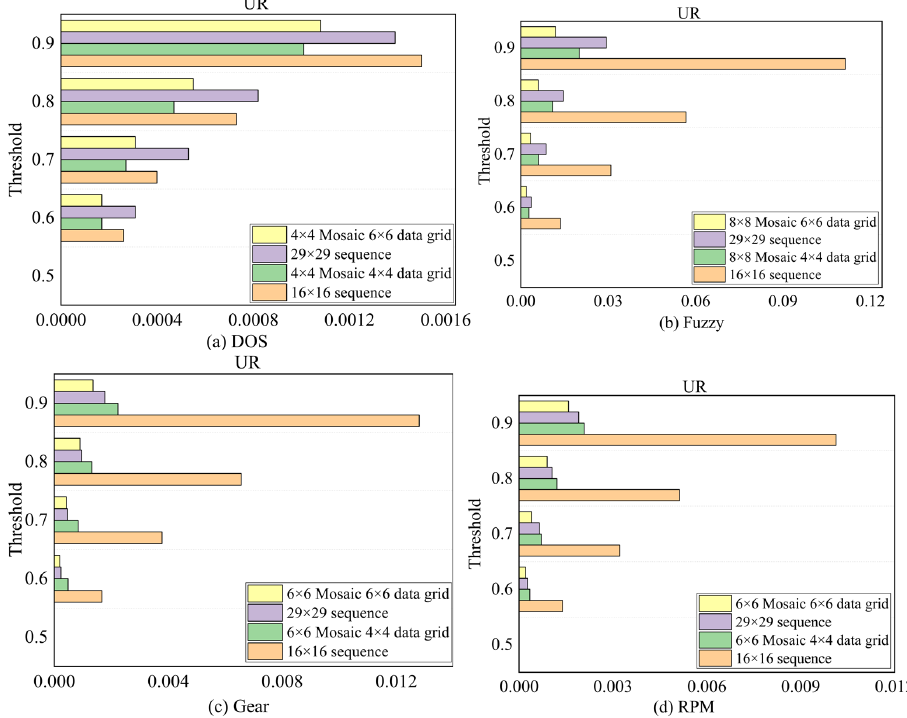
Figure 10. Comparison of the UR values, for different models.